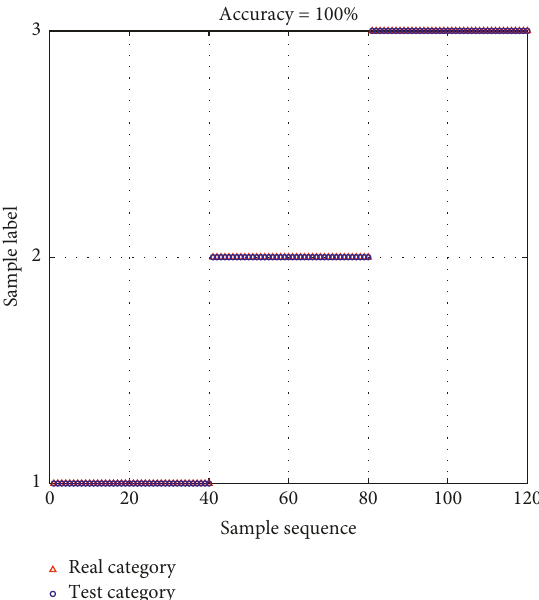
Figure 8: The spiral-bevel gear fault diagnostic results by using CEEMDAN-based permutation entropy and